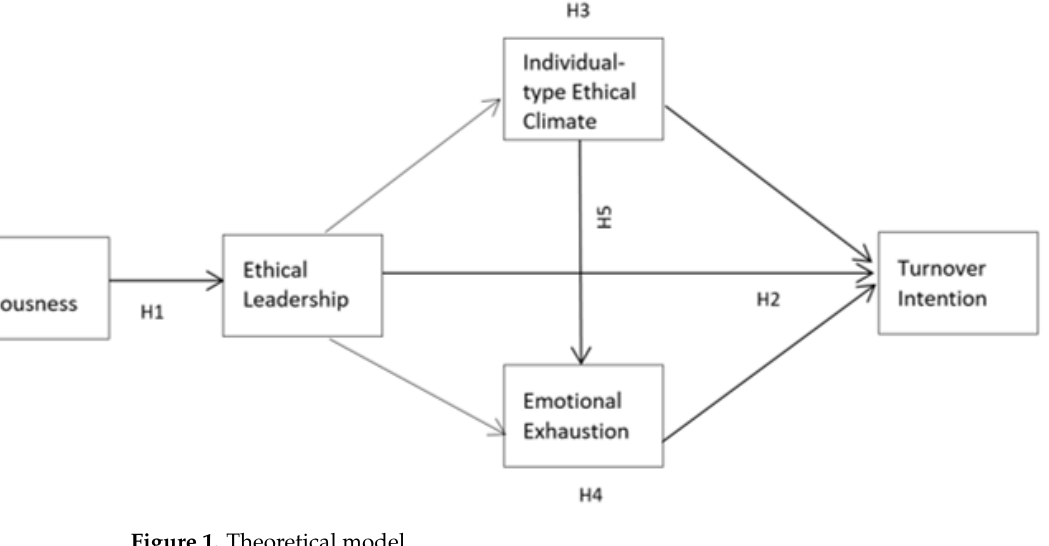
Figure 1. Theoretical model.